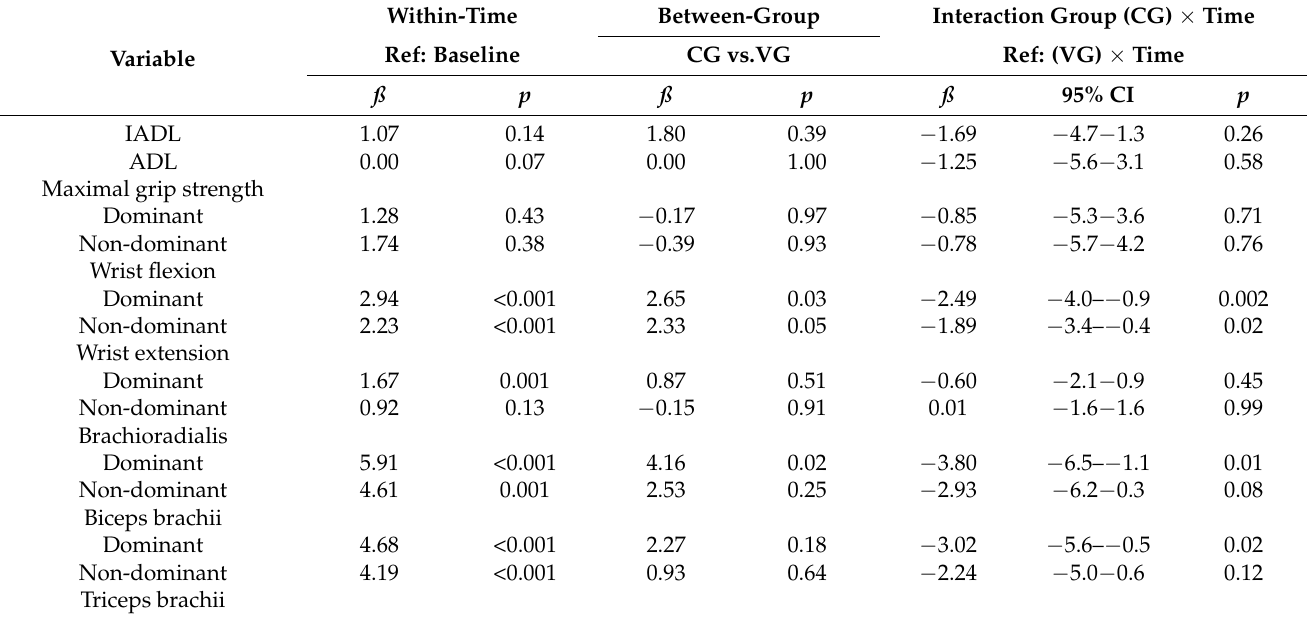
Table 3. Evaluation of the Intervention on Outcome Indicators Based on GEE